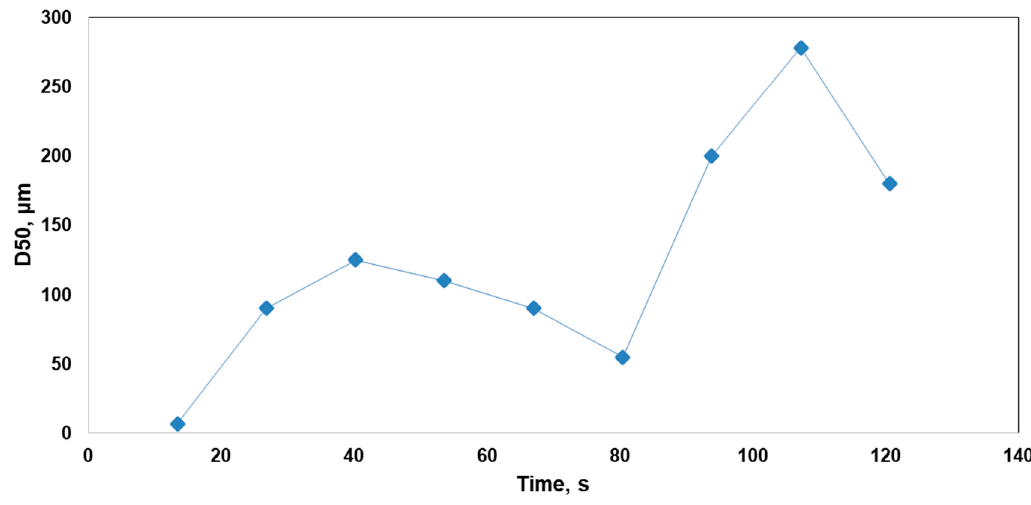
Figure 3. Results of D50 particle size of copper precipitates with respect to the capture time of image in the microscope.